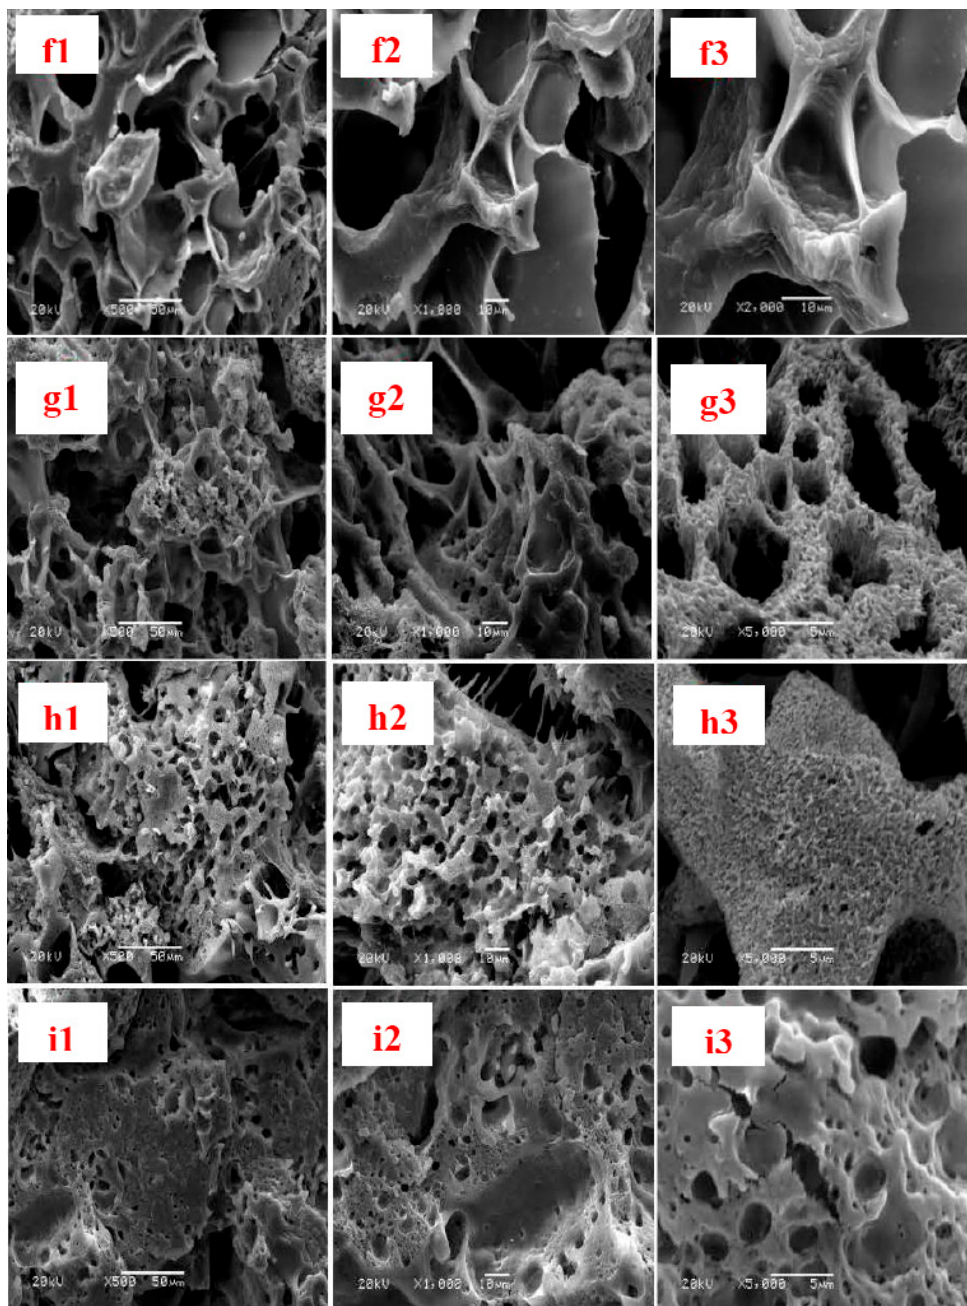
Figure 3. SEM images of fracture surfaces at various magnification: ( a1–a3 ) neat MC membrane; ( b1 – b3 ) MC / PLA (99:1) membrane; ( c1 – c3 ) MC / PLA (97:3) membrane; ( d1 – d3 ) MC / PLA (95:5) membrane;